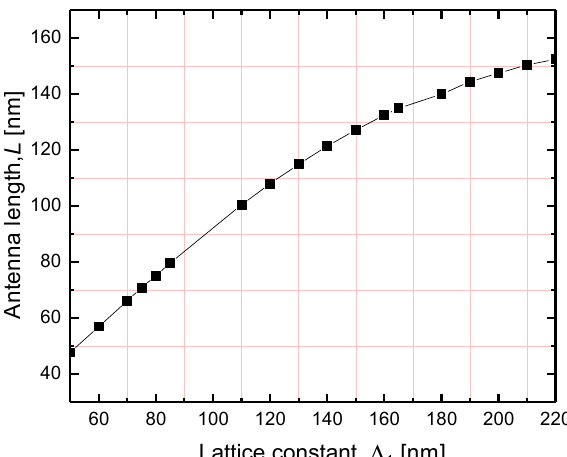
Figure A3. Dependence of the resonance antenna length L on the longitudinal lattice period Λ 1 at the fixed Λ 2 = 970